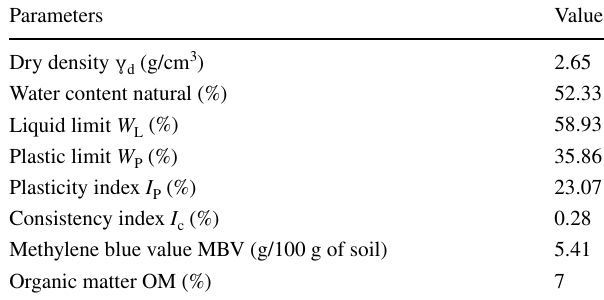
Table 1 Physical characteristics of the